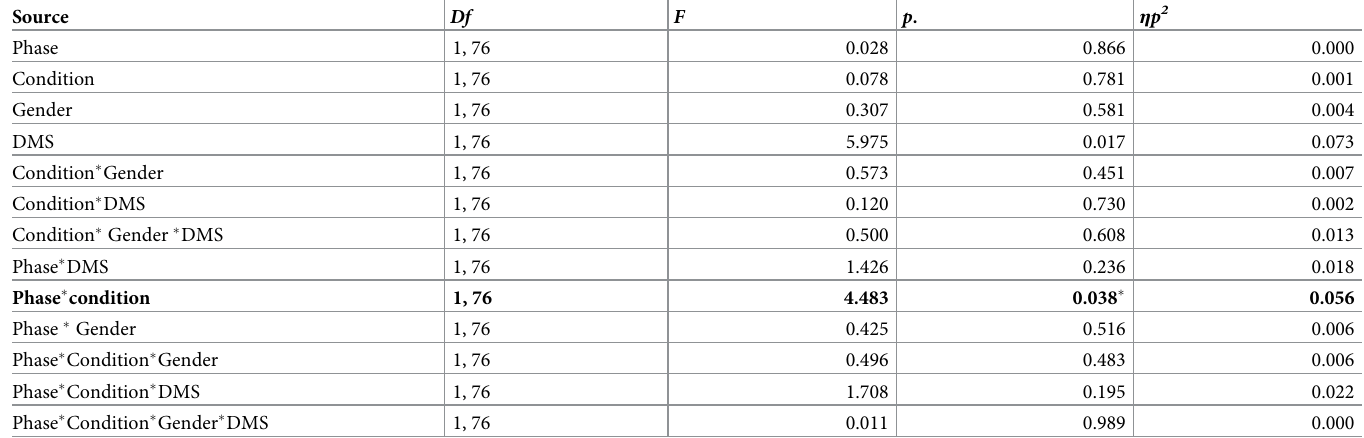
Table 9. Tabulated values for mixed ANOVA with phase (pre- versus post-manipulation preference for muscularity scores) as the repeated measures variable, and condition and participant gender as between-participant factors with DMS as covariate. Critical tests of our hypotheses are shown in